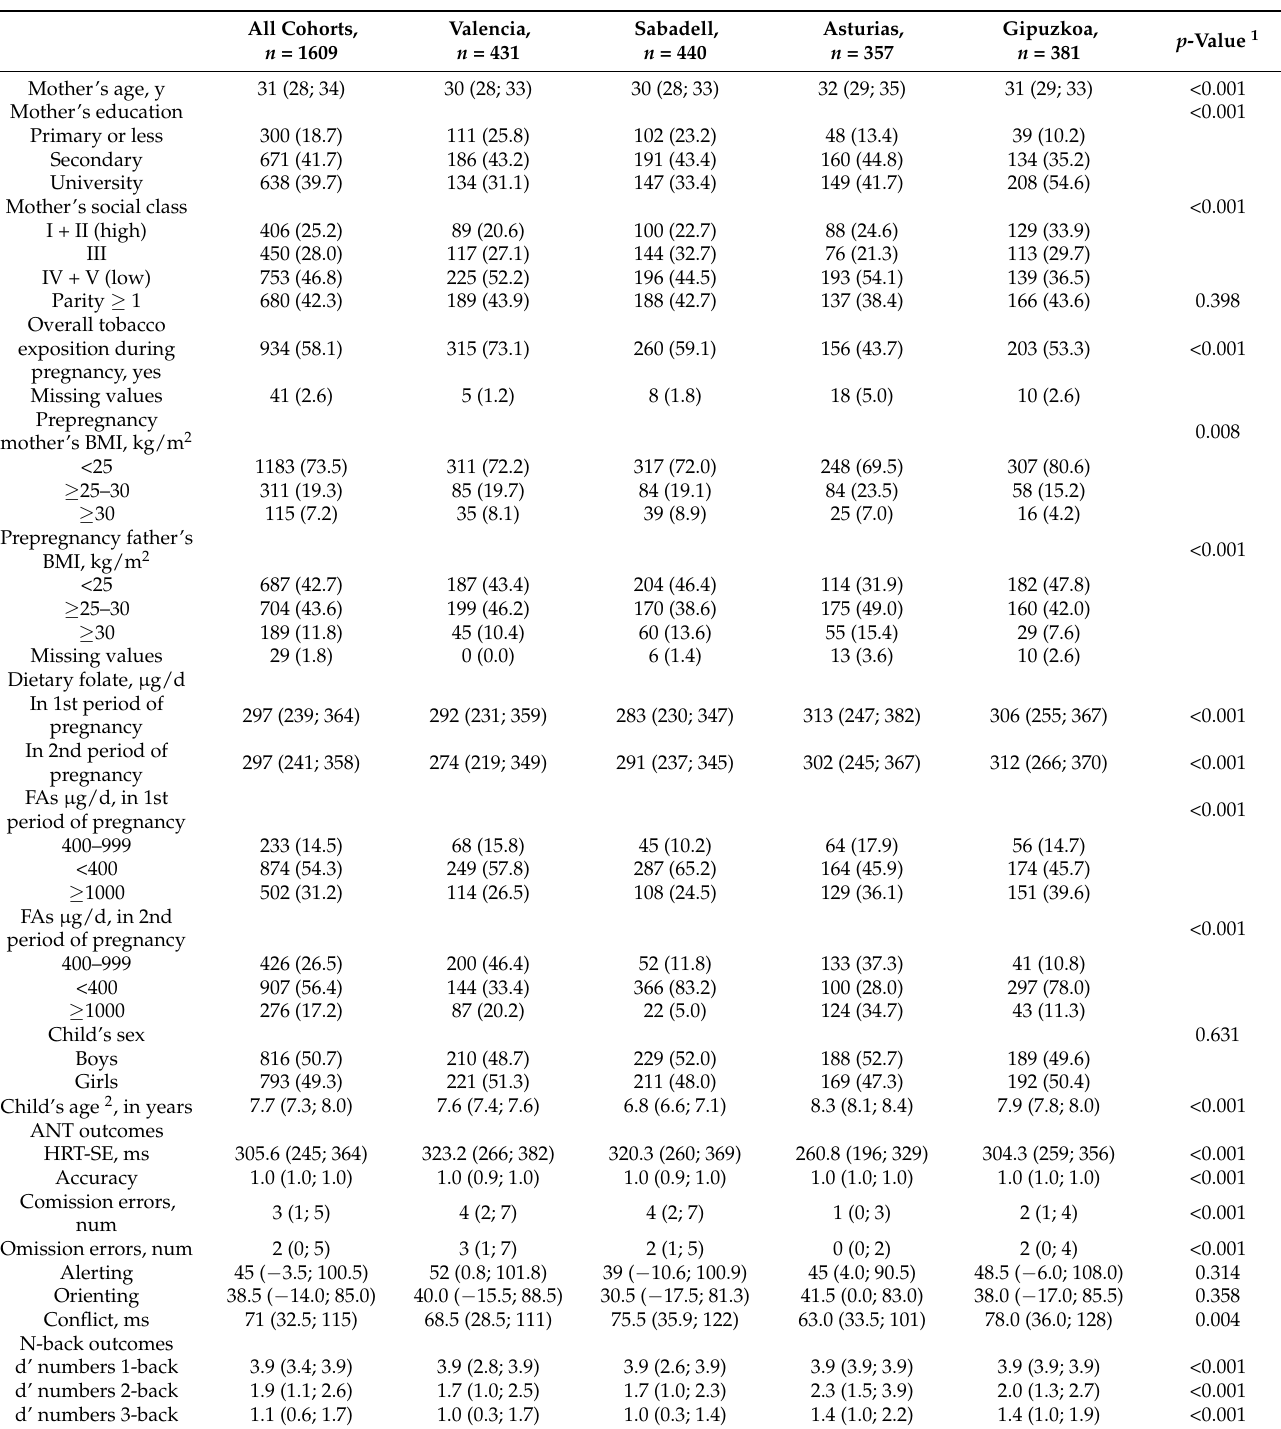
Table 1. Socio-demographic, lifestyle, and obstetric characteristics of parents and children at 7-year follow-up of INMA cohort study, Spain,